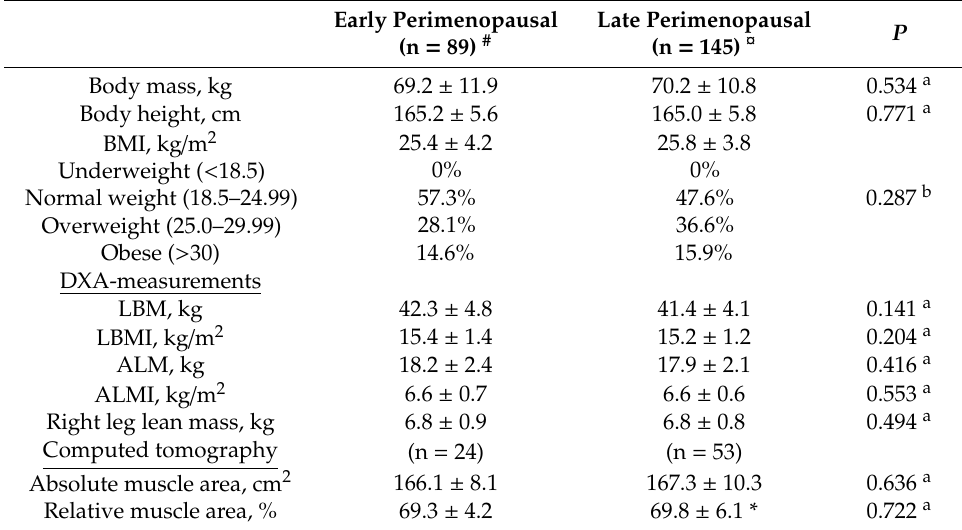
Table 2. Anthropometry and lean and muscle mass variables of perimenopausal women in the ERMA baseline population (n =